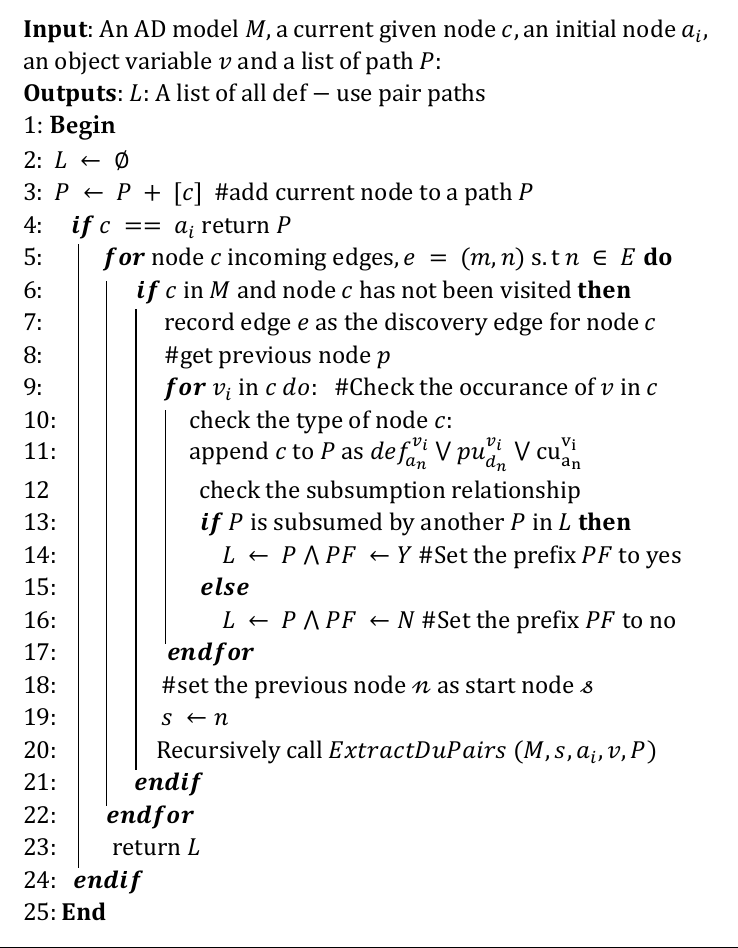
Algorithm 1. ExtractDuPairs ( M, c, a i , v, P []: The algorithm for automatically generating the def—use pair